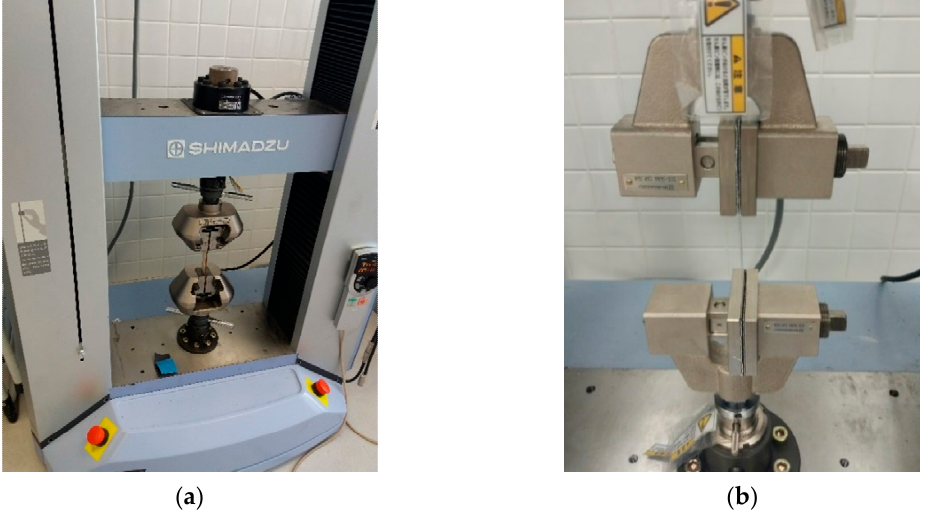
Figure 8. Testing machine with clamps for tensile tests: ( a ) testing machine for the experimental ( b ) clamps with specimen in the